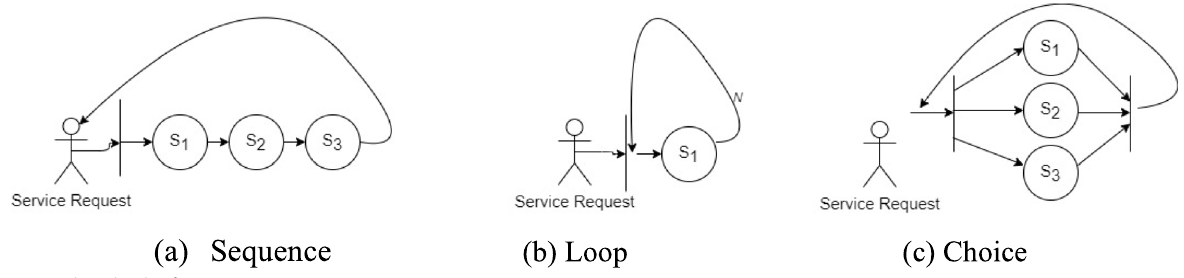
Fig. 2 Three kinds of service composition structures